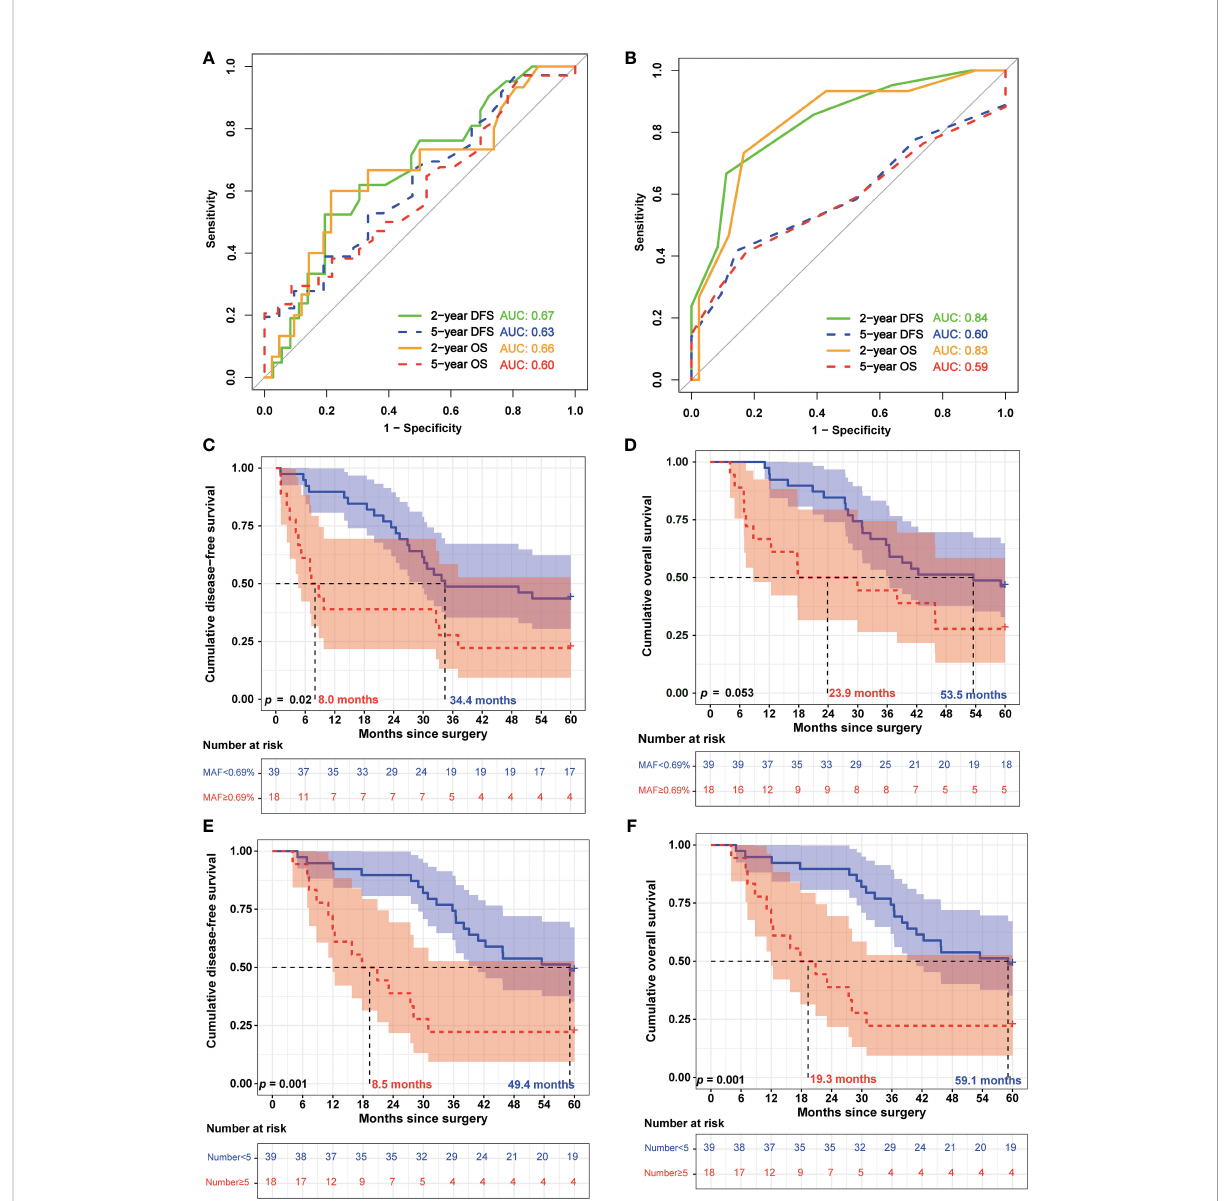
FIGURE 3 Circulating tumor DNA features were associated with the prognosis of patients with esophageal squamous cell carcinoma. (A) Receiving operating characteristic (ROC) curves were used to assess the ef fi ciency of the mean circulating tumor DNA (ctDNA) mutant allele frequency (MAF) for predicting 2-year and 5-year disease-free survival (DFS) and overall survival (OS). (B) ROC curves of the number of ctDNA variants for predicting 2- and 5-year DFS and OS. (C) Kaplan – Meier analysis of DFS of patients with esophageal squamous cell carcinoma (ESCC) was strati fi ed by mean ctDNA MAF. (D) Kaplan – Meier analysis of OS of patients with ESCC was strati fi ed by mean ctDNA MAF. (E) Kaplan – Meier analysis of DFS of patients with ESCC was strati fi ed by the number of ctDNA variants. (F) Kaplan – Meier analysis of OS of patients with ESCC was strati fi ed by the number of ctDNA